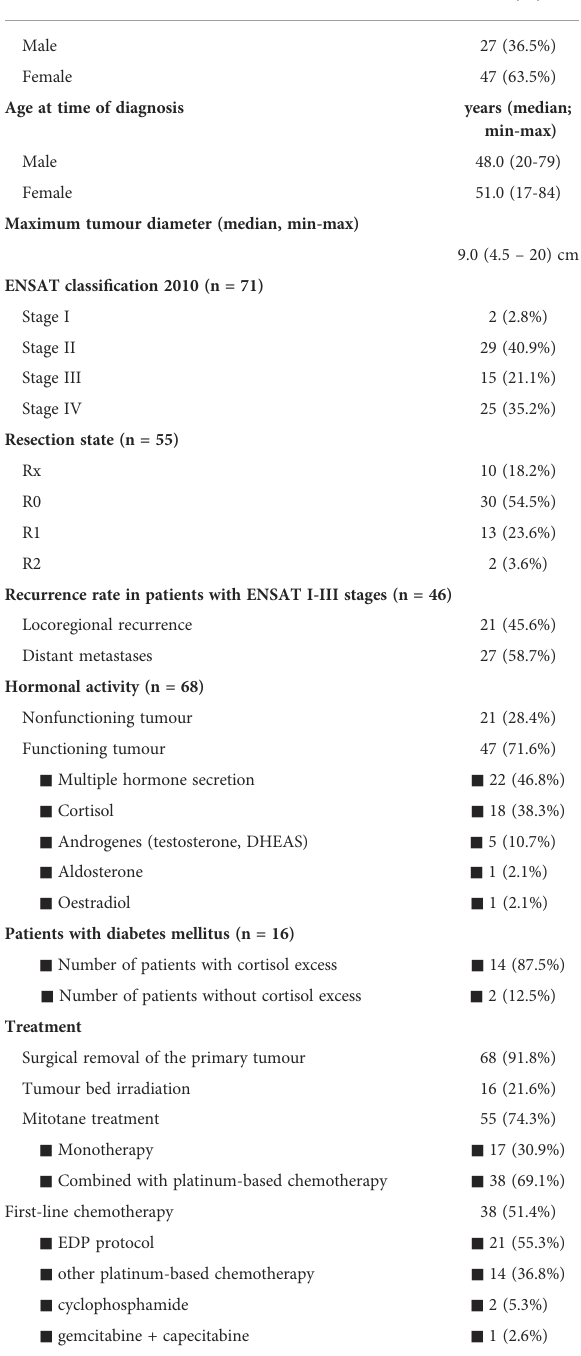
TABLE 1 Descriptive statistics of our ACC patients ’ cohort (n =